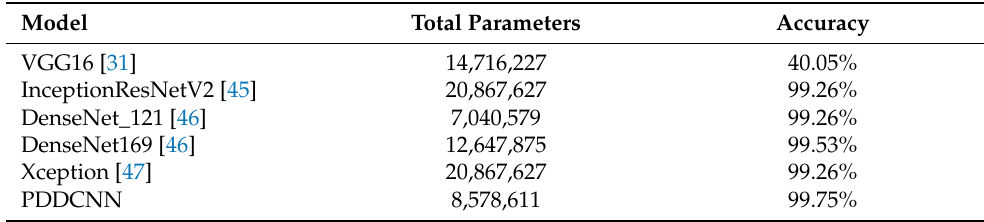
Table 10. Comparison with state-of-the-art